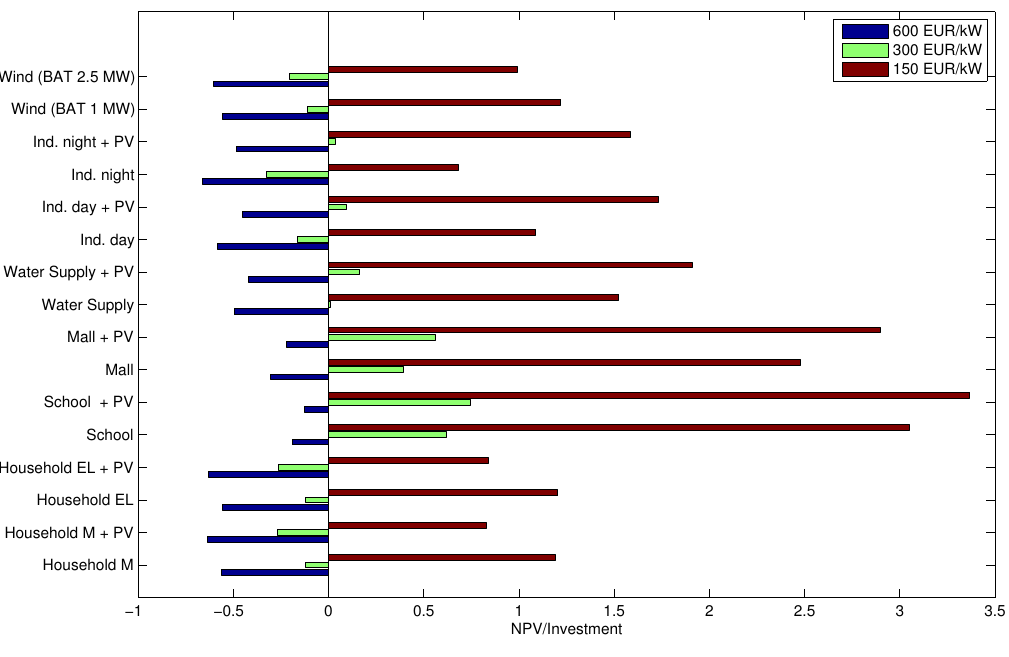
Figure 12. NPV/Investment Ratio for different end-users and battery capital costs using CROPEX prices.